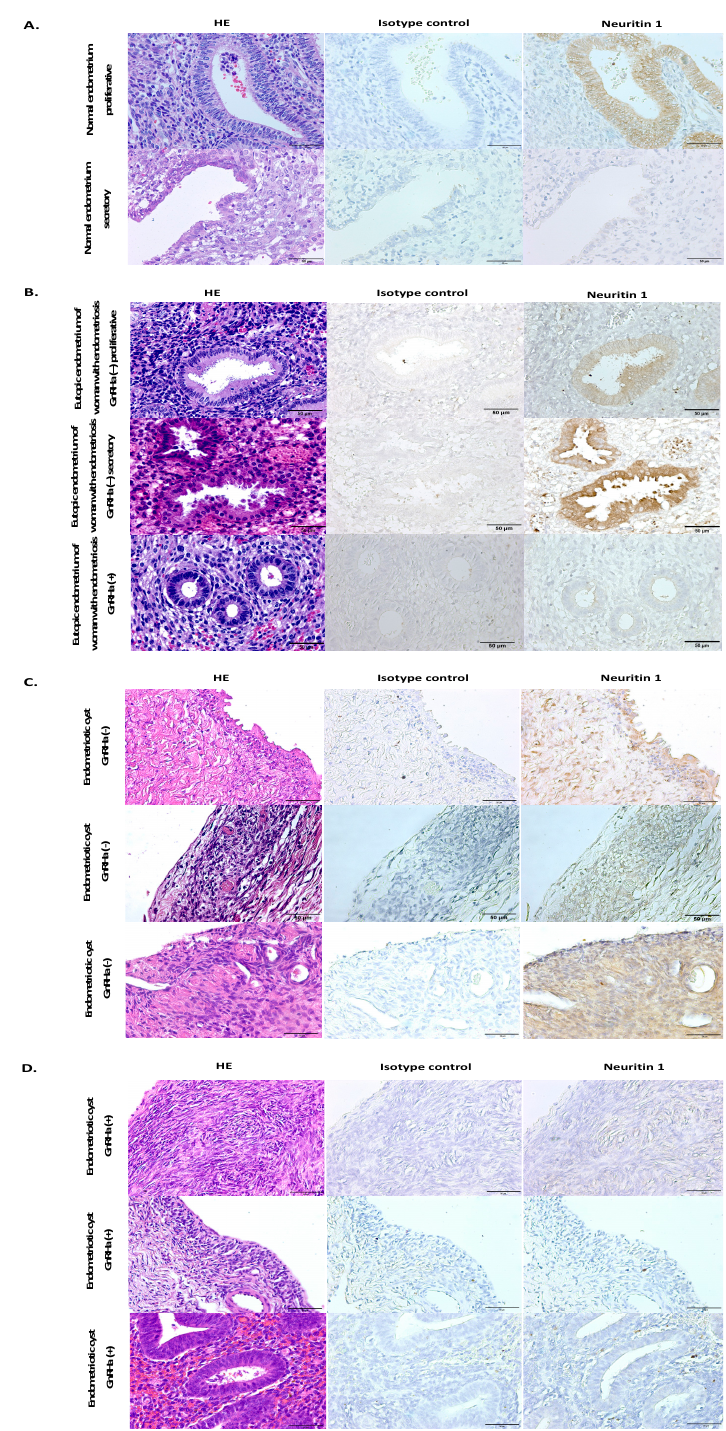
Figure 3. NRN1 protein expression and localization in endometrial tissues. Immunohistochemistry was used to localize the NRN1 protein in the normal endometrium ( A ), in the eutopic endometrium of women with endometriosis ( B ), and in endometriotic cysts with ( D ) and without ( C ) GnRHa treatment. Positive NRN1 staining is seen as a dark-brown precipitate on the surfaces of the cells. Hematoxylin and eosin staining were performed in each specimen to provide a tissue overview. Magnification, 400 × ; scale bar, 50 µ